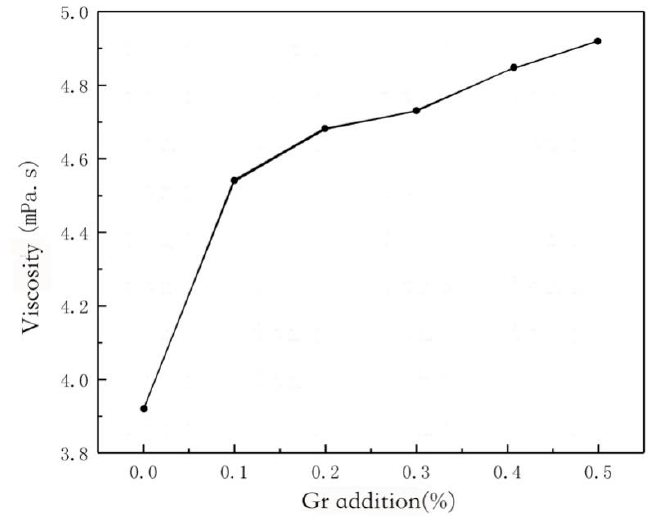
Figure 11. Relationship between viscosity and Gr addition.